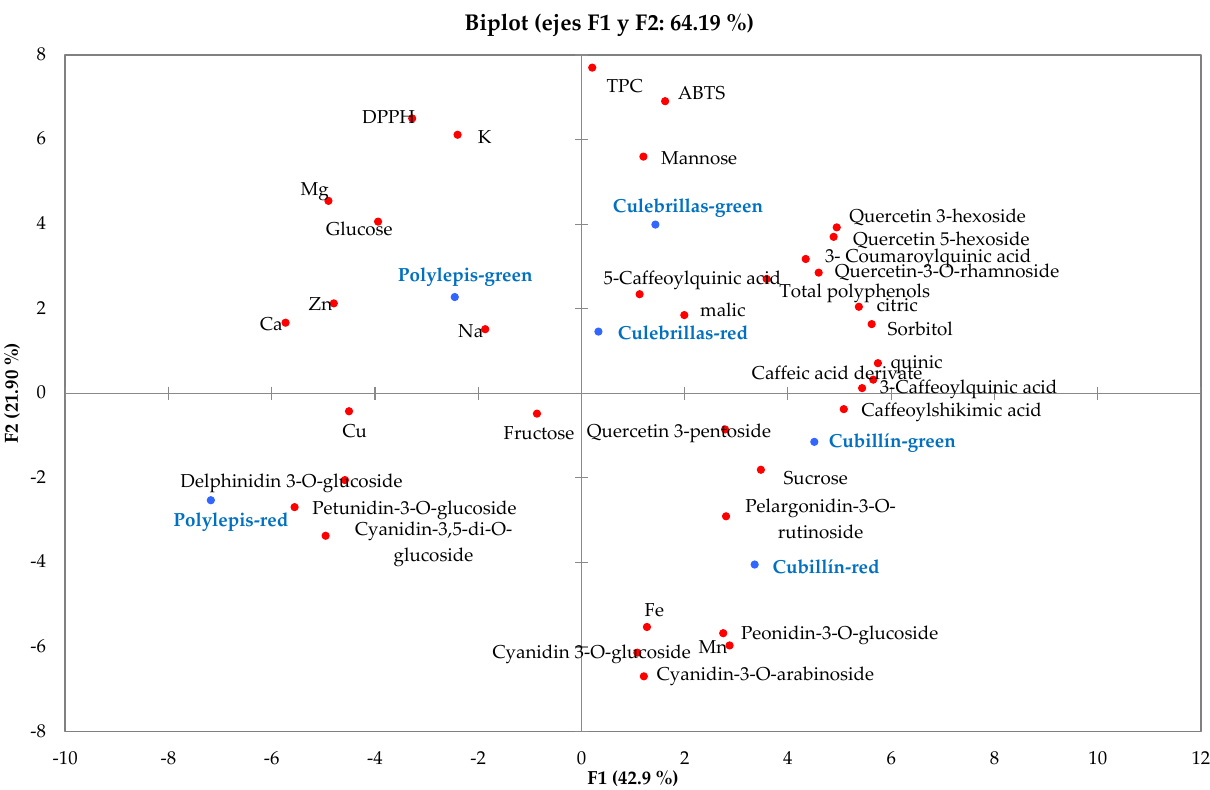
Figure 2. Biplot of principal components analysis (PCA) means showing the relationship among phytochemical parameters and effects of environmental zones (Polylepis, Cubillín and Culebrillas) and stage of development of the fruit of mortiño berries (stage 7 green and stage 8 red).